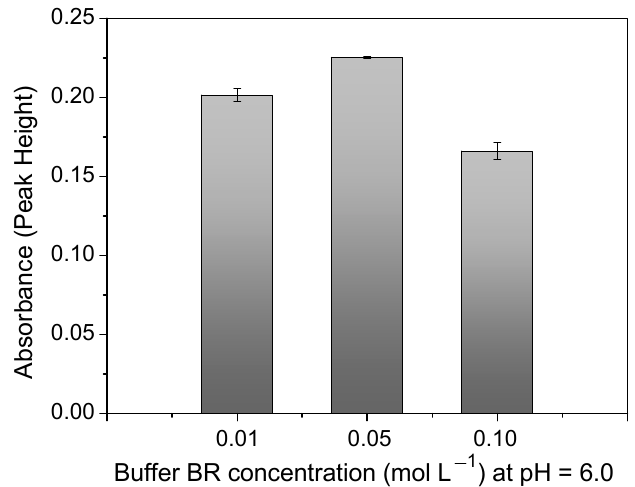
Figure 7. Study of BR buffer concentration at pH = 6.0 on Cu 2+ absorbance signal using polymer in FIA system. Conditions: mass of polymer = 50.0 mg; concentration of Cu 2+ = 100.0 µg L − 1 ; sample loop = 14.0 mL; preconcentration/elution flow rate = 7.0 mL min − 1 ; eluent = 1.50 mol L − 1 HCl.